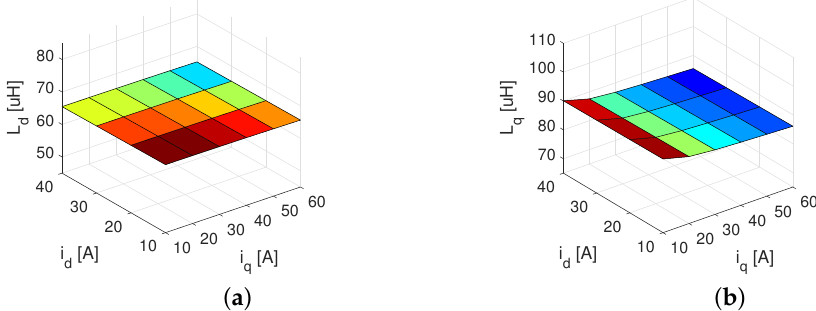
Figure 10. FEA results of inductance maps: ( a ) d -axis inductance and ( b ) q -axis inductance.